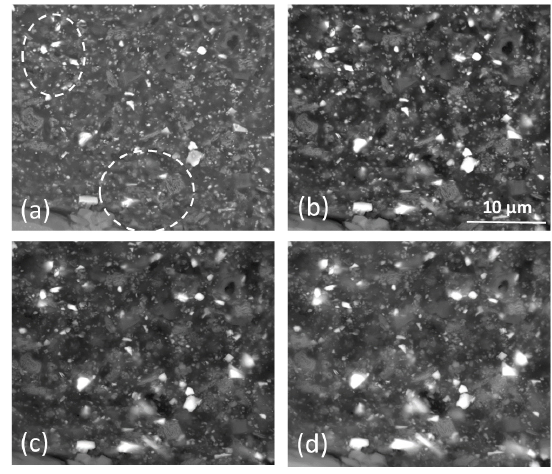
Figure A1. Backscatter electron images collected at ( a ) 10 kV, ( b ) 15 kV, ( c ) 20 kV and ( d ) 25 kV. Dashed ellipses highlight regions where the backscatter contrast changes significantly with accelerating voltage.